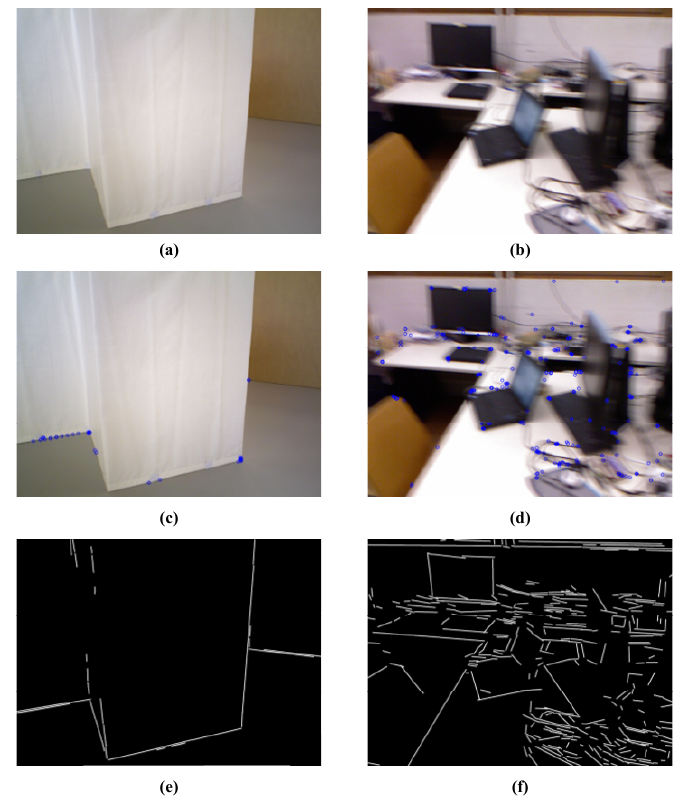
Figure 2. The performance of point and line features in areas of low texture and motion blur. ( a ), ( b ) A low-texture scene and motion blur scene, respectively. By comparing the ORB feature points (see figures ( c ) and ( d )) and LSD line segments (see figures ( e ) and ( f )) extracted from the images, it can be seen that the line segments are more responsive to the environment structure infor- mation.